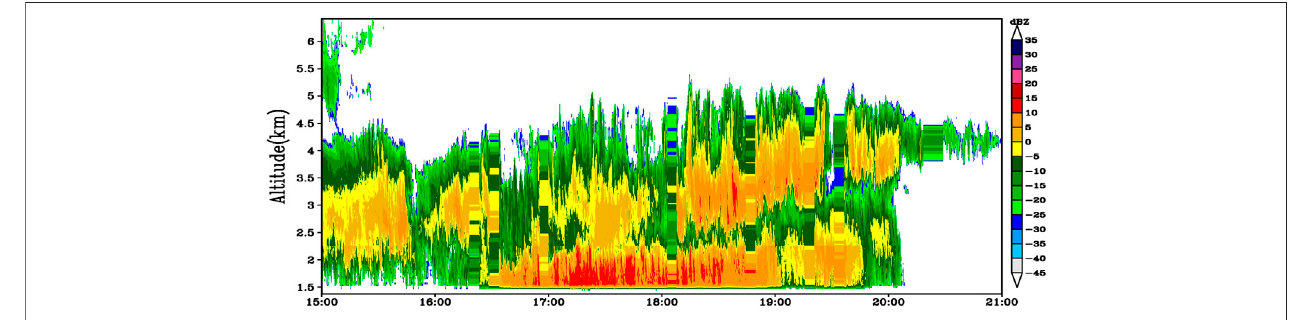
FIGURE 4 | Evolution of re fl ectivity factor (units: dB Z ) observed by cloud radar from 1500 BJT to 2100 BJT Jan 27, 2021.